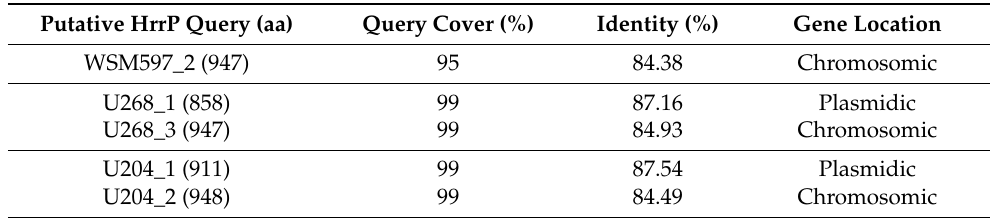
Table 6. M16 peptidases identified in U204, U268, and WSM597 genomes by BlastP against HrrP aminoacidic sequence of E. meliloti USDA1963 (AJT61688.1) with a query coverage greater than 90%. aa: total aminoacids number. Putative HrrP Query